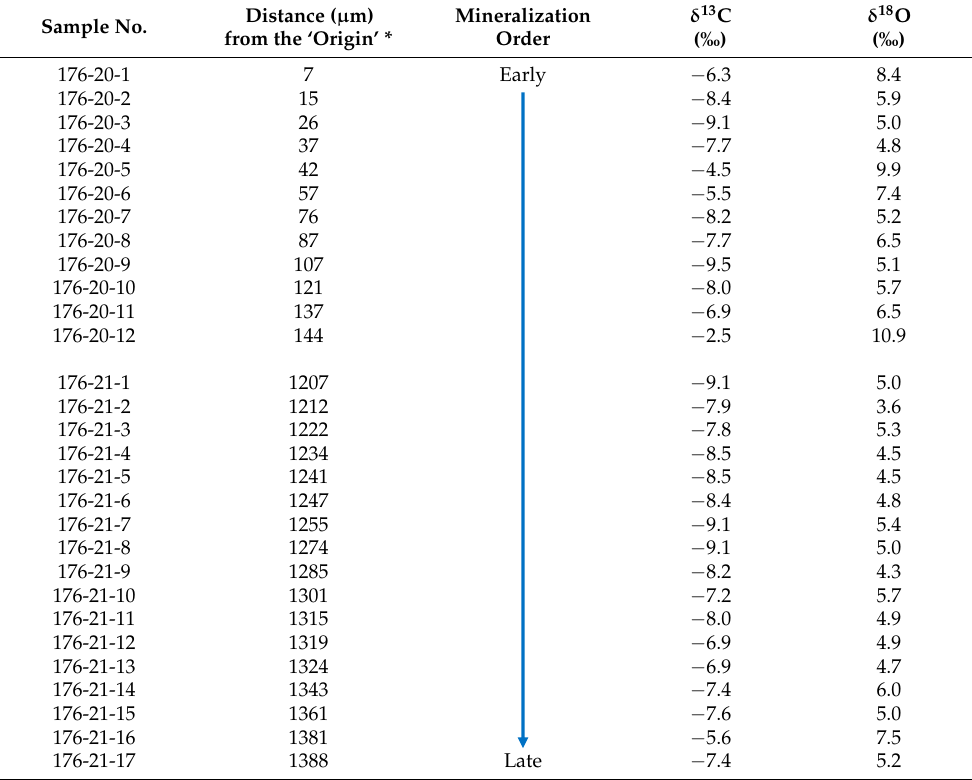
Table 4. Microanalyses of 176-20 and 176-21 cutoff (12 µ m-width sample set; Figure 4c) from 20100317 sample. Sample No.